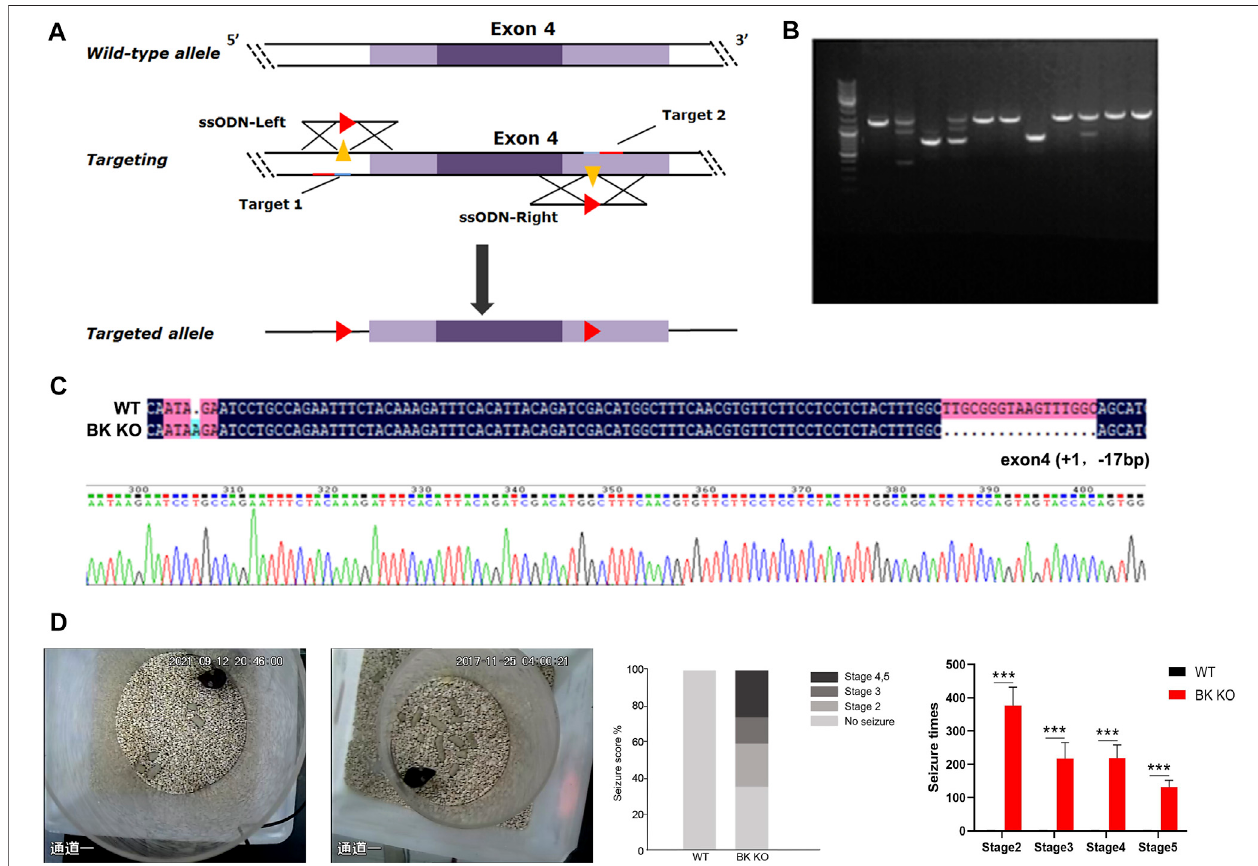
FIGURE5| Construction ofBKKOmicewithspontaneousepilepsy. (A) SchematicoutliningthegenerationofBKknockoutmiceusingtheCRISPR/Cas9system. The targeting sites of KCNMA1 (gene encoding the α subunit of BK, BK α ) are shown. (B,C) BK KO mice were established by breeding BK +/ − males and females. The targeted fragment of KCNMA1 was ampli fi ed by PCR using genomic DNA templates, and the BK channel deletion was con fi rmed by sequencing. Genome sequencing ofBKKOmiceshowedaframeshiftmutation(-16 bp)inexon4. (D) SpontaneousepilepticbehaviorofBKKOmice.TheproportionofdifferentseizurestagesinBK KO/WT mice was observed for 2 h (*** p < 0.001, n (cid:2)